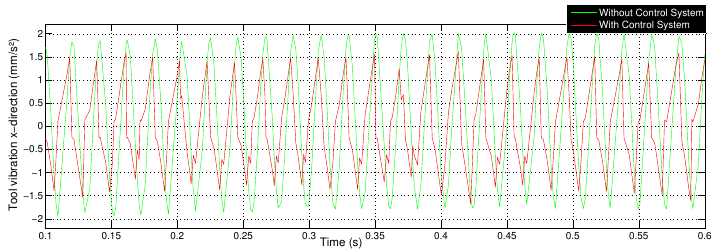
Figure 4. Tool vibration along x -direction using DSMC.